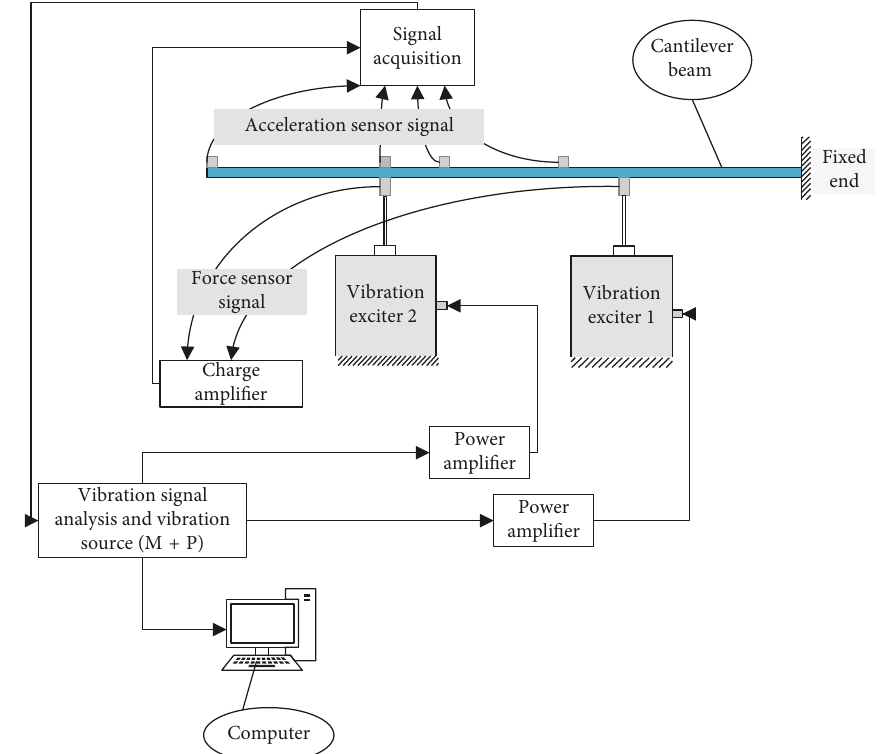
Figure 2: Diagrammatic sketch of cantilever beam